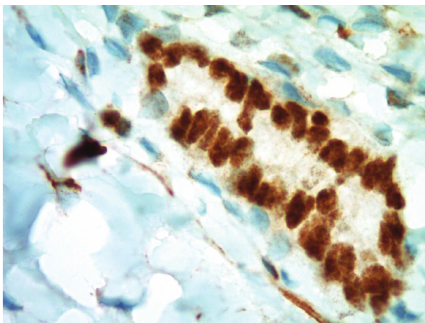
Figure 4: Photomicrograph of glandular epithelial rest in post- neoadjuvant ipsilateral axillary sentinel lymph node capsule (WT1 immunohistochemical study, original magnification